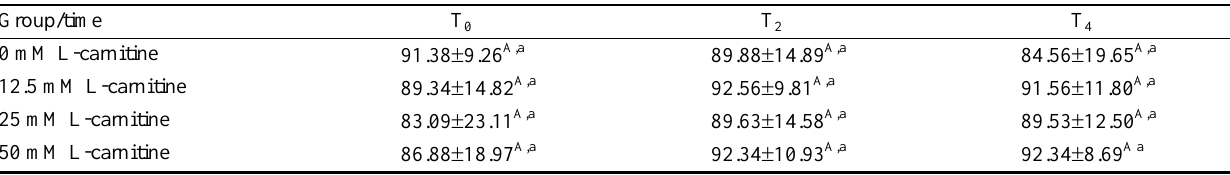
Table 4. Sperm DNA integrity (%) of post-thawed cauda epididymal spermatozoa after thawing for 0 h (T0), 2 h (T2) and 4 h (T4) in each experimental group (mean  SD) Group/time